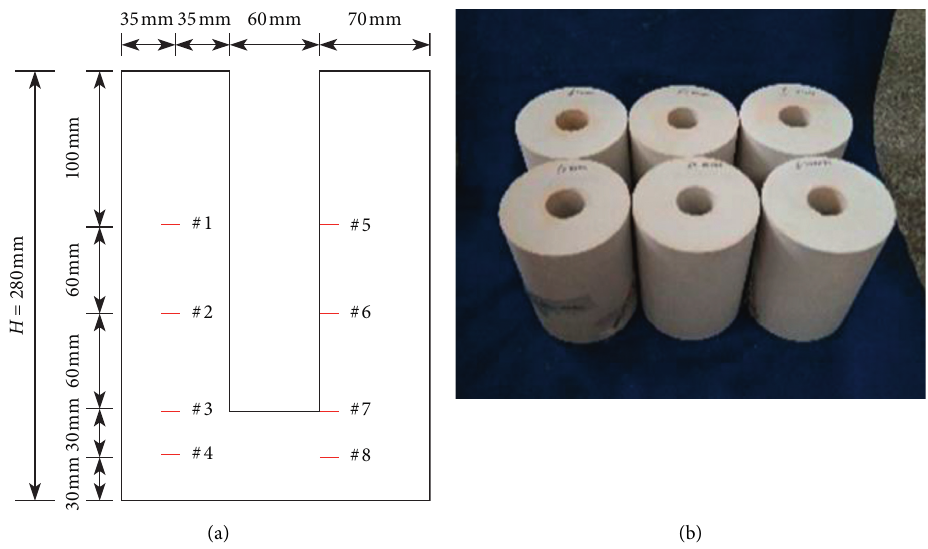
Figure 3: (a) Location and layout of strain gauges; (b) overview of cement mortar specimens. Table 1: Mechanical and physical parameters of cement mortar material and sandstone.